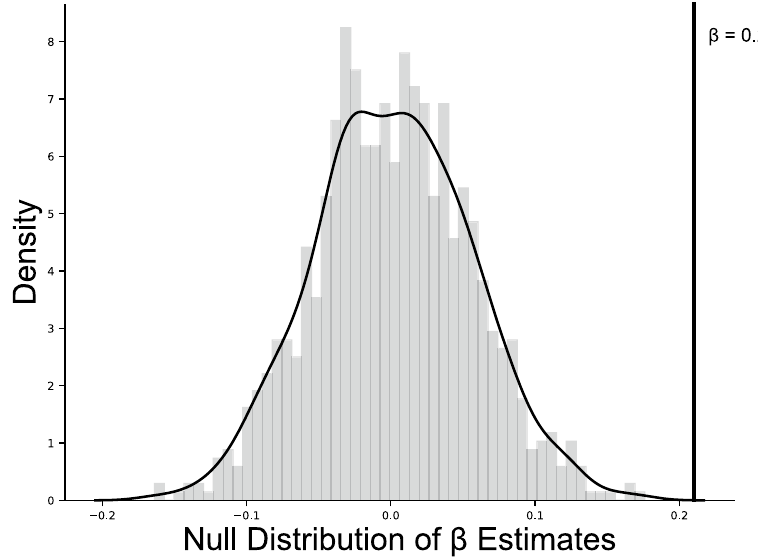
Figure 6. Results of a permutation test comparing the true estimate (β = 0.21) of the association between entrainment synchrony and speaker-listener pupillary synchrony to 1000 permutations shuffling participants’ entrainment synchrony values. The true relationship between entrainment synchrony and speaker-listener pupillary synchrony fell significantly outside these two